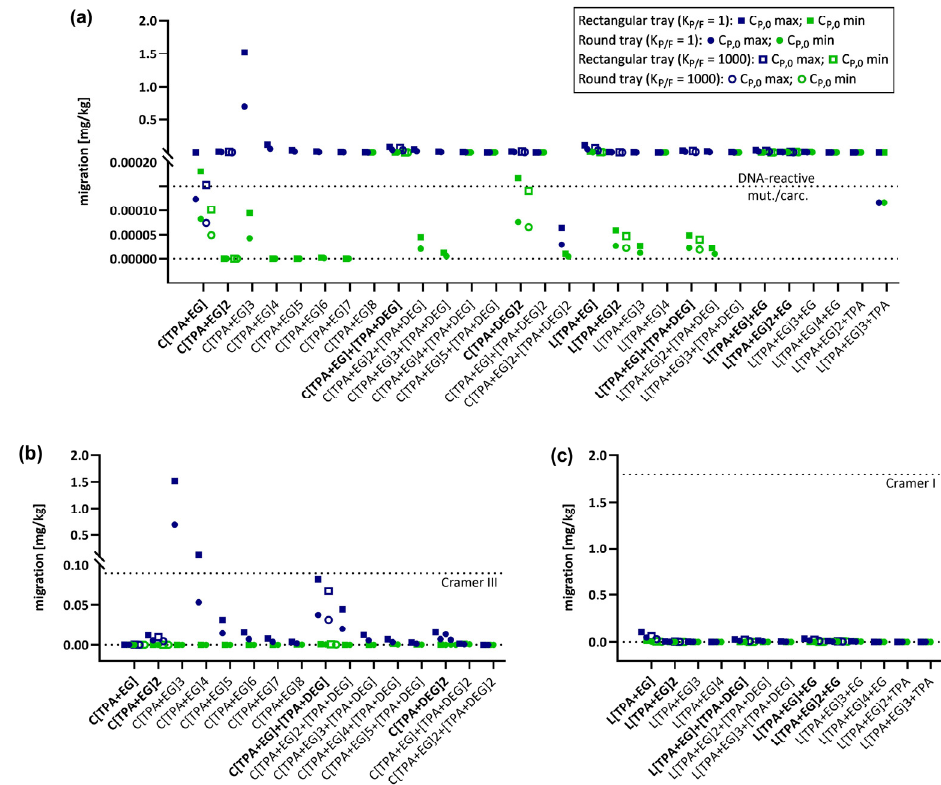
Figure 2. Graphical representation of predicted migrations using the A P model (realistic case). Migration of PET oligomers for which C P,0 values were available was predicted for PET trays under long-term heating conditions (100 ◦ C, 2 h) and evaluated for the exceeding different safety thresholds. Oligomer names in bold represent molecules for which both K P/F = 1 and K P/F = 1000 were used for predictions. ( a ) Modeled migration of all 29 PET oligomers and their evaluation against the DNA-reactive mutagens/carcinogens safety threshold of 0.15 µ g/kg. ( b ) Modeled migration of cyclic PET oligomers and their evaluation against the Cramer Class III threshold of 90 µ g/kg. ( c ) Modeled migration of linear PET oligomers and their evaluation against the Cramer Class I threshold of 1.8